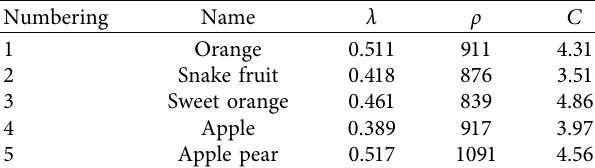
Table 1: Fruit thermal